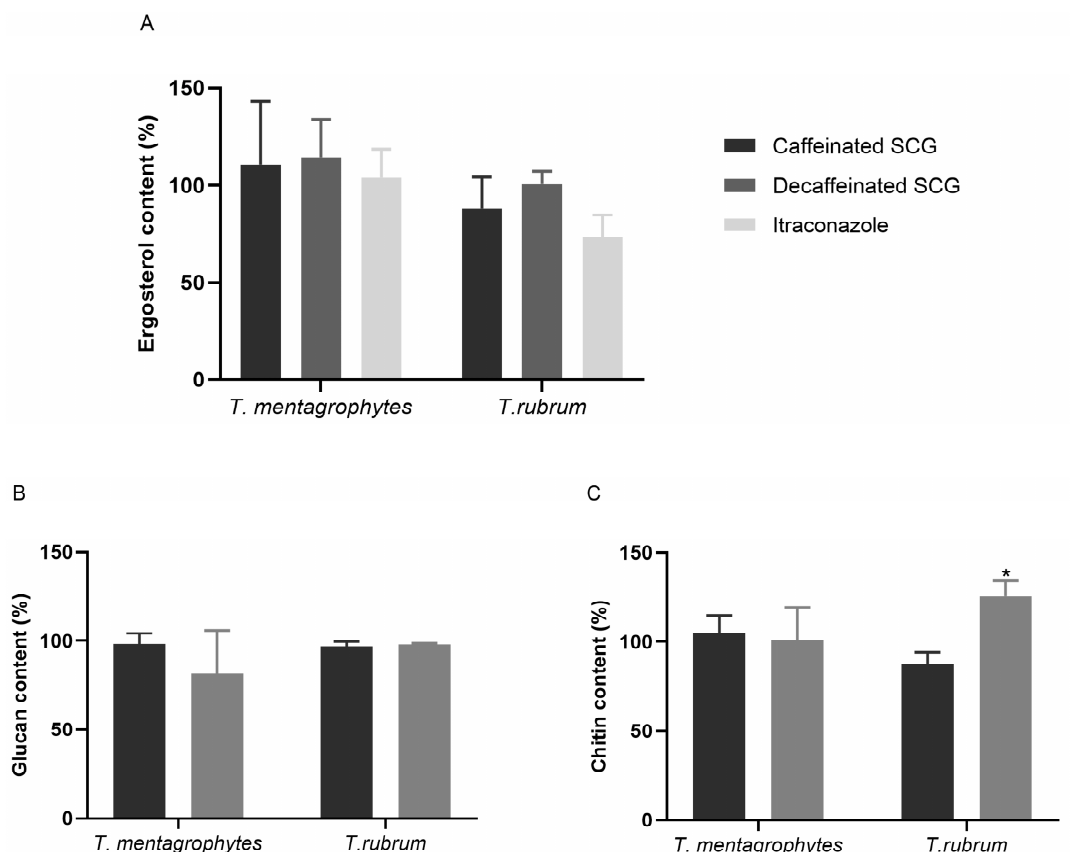
Figure 2. Effects of caffeinated and decaffeinated SCG extracts on cell membrane and cell wall components of filamentous fungi. T. mentagrophytes treated with 137.5 µ g/mL of caffeinated SCG extract, 300 µ g/mL of decaffeinated SCG extract, and 0.016 µ g/mL of itraconazole. T. rubrum treated with 137.5 µ g/mL of caffeinated extract, 150 µ g/mL of decaffeinated extract, and 0.016 µ g/mL of itraconazole. ( A ) Ergosterol, ( B ) β -(1,3)-glucan, and ( C ) chitin contents. Results are expressed as mean ± standard error and a representation of three independent experiments performed in triplicate, * p < 0.05 (Dunnett’s post-hoc test). Data were normalized to control values.